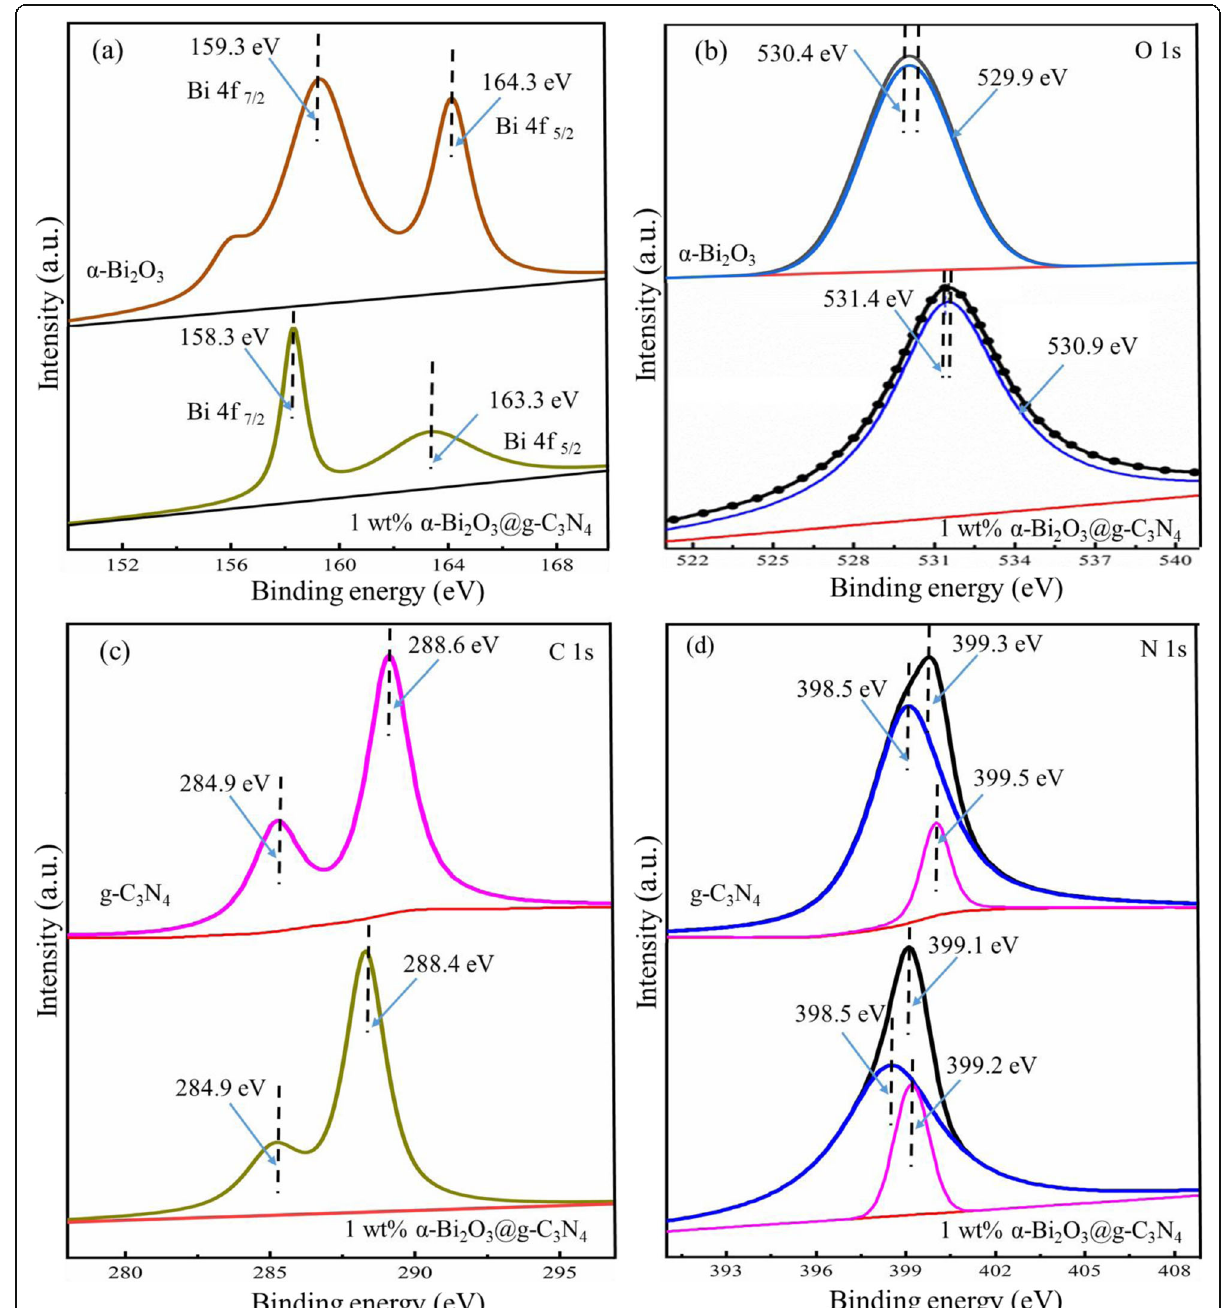
Fig. 5 High-resolution XPS spectra of g-C 3 N 4 , α -Bi 2 O 3 and 1 wt% α -Bi 2 O 3 @g-C 3 N 4 ( a ) Bi 4f; ( b ) O 1s; ( c ) C 1s; ( d ) N